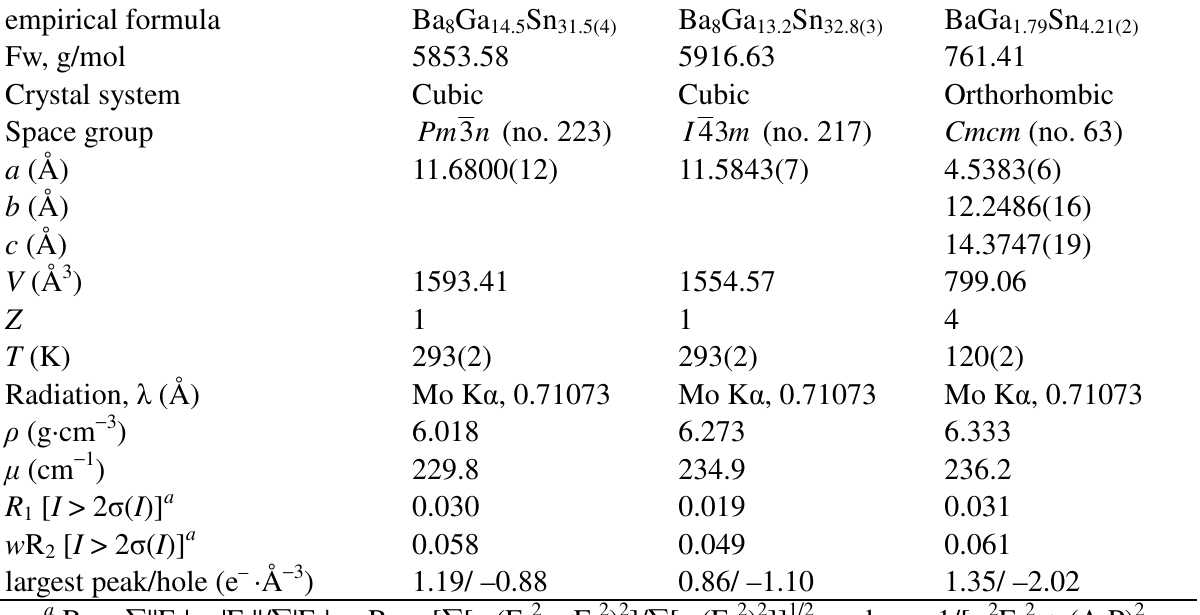
Ga Sn 8 14.5 31.5(4)